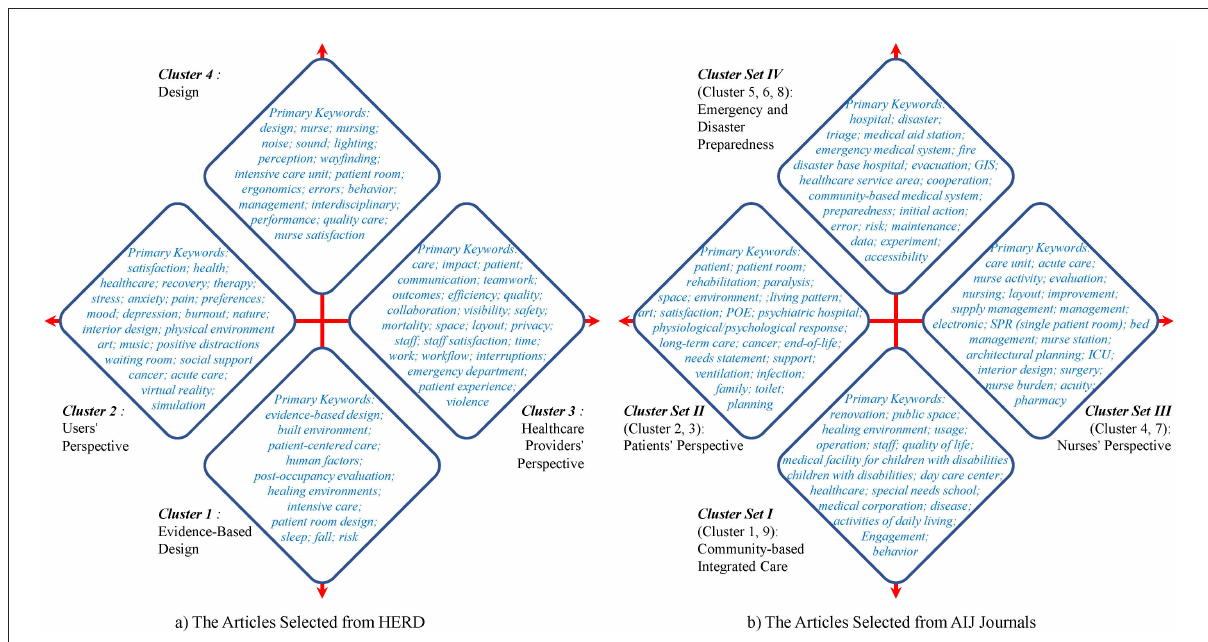
FIGURE4 Comparative study on characteristics of four clusters or cluster sets between the USA and Japan. (A) The articles selected from HERD. (B) The Articles Selected from AIJ journals.